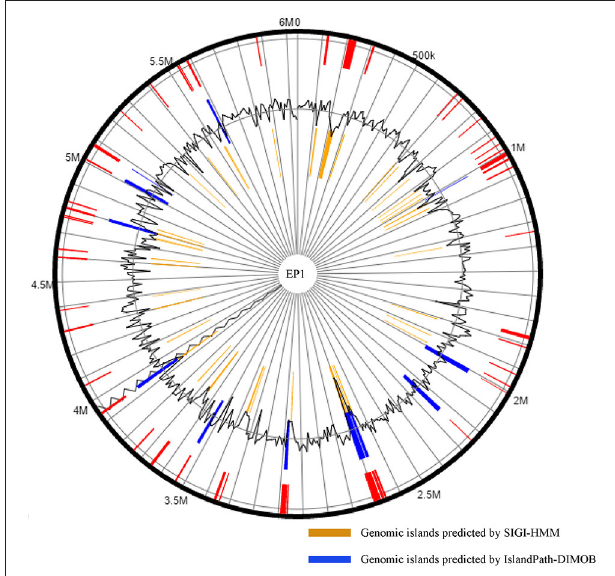
FIGURE 6 | Genomic islands distribution in strain EP1 genome.